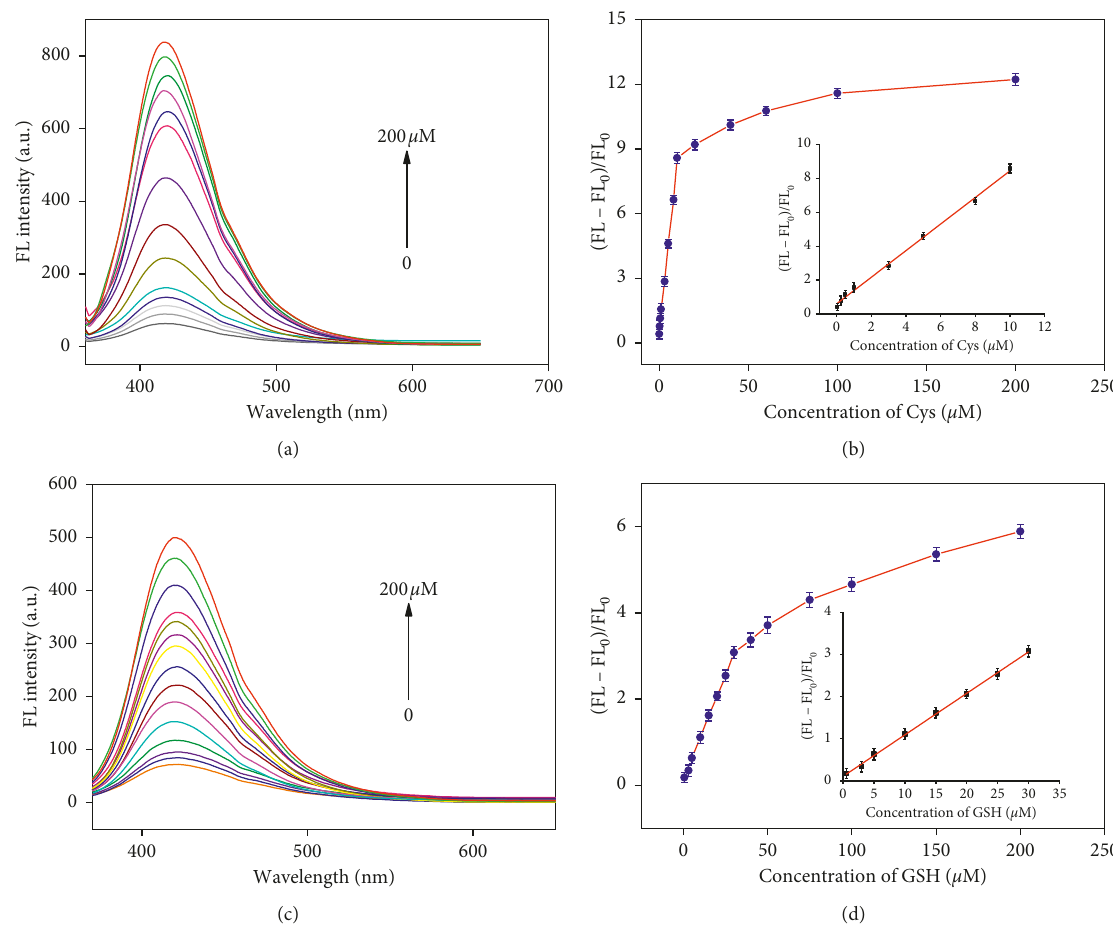
Figure 6: FL spectra of NRPCNSs in the presence of Ag + (80 µ M) and different concentrations of (a) Cys (0, 0.05, 0.25, 0.5, 1, 3, 5, 8, 10, 20, 40, 60, 100, and 200 µ M, bottom to top, excitation at 355nm) and (c) GSH (0, 0.2, 3, 5, 10, 15, 20, 25, 30, 40, 50, 75, 100, 150, and 200 µ M, bottom to top, excitation at 355nm). Plots of (b) and (d) show the enhanced FL signals ((FL − FL 0 )/FL 0 ) versus Cys and GSH concentration, respectively. Insets of (b) and (d) show the linear dependence of fluorescence intensities ((FL − FL 0 )/FL 0 ) on corresponding Cys and GSH concentrations, respectively (error bars represent the standard deviation of three measurements).